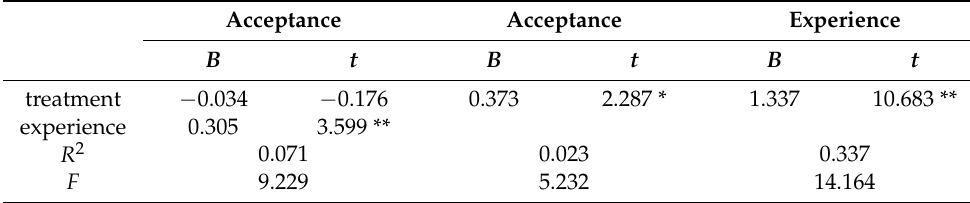
Table 1. Mediated model test of experience.